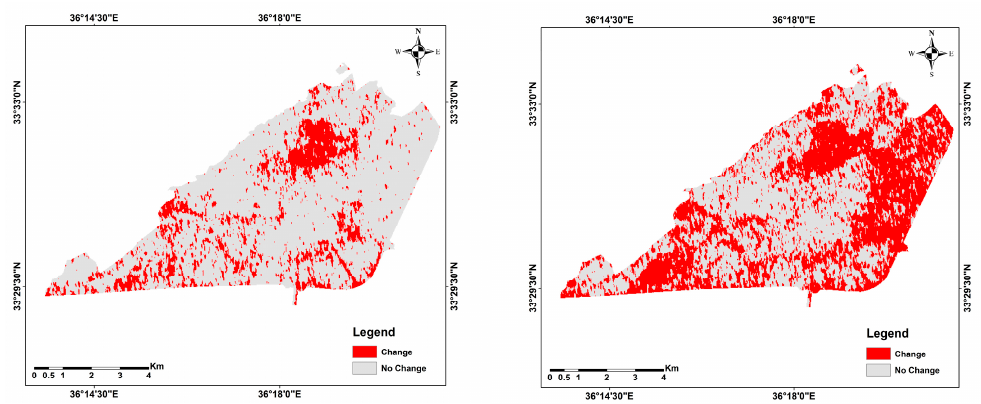
Figure 8. Damascus coherence images classified into change and no change (31 October 2016 on the left and 05 April 2017 on the right ).